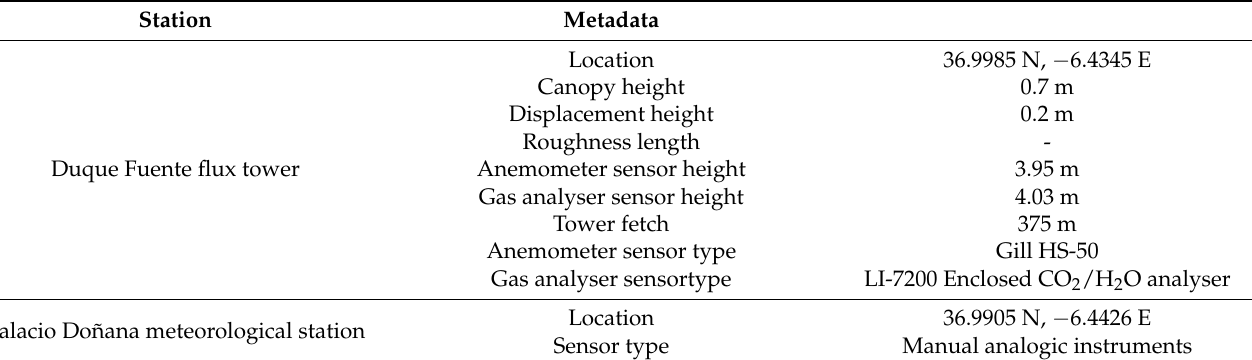
Table 2. Metadata of the ICTS-RBD monitoring